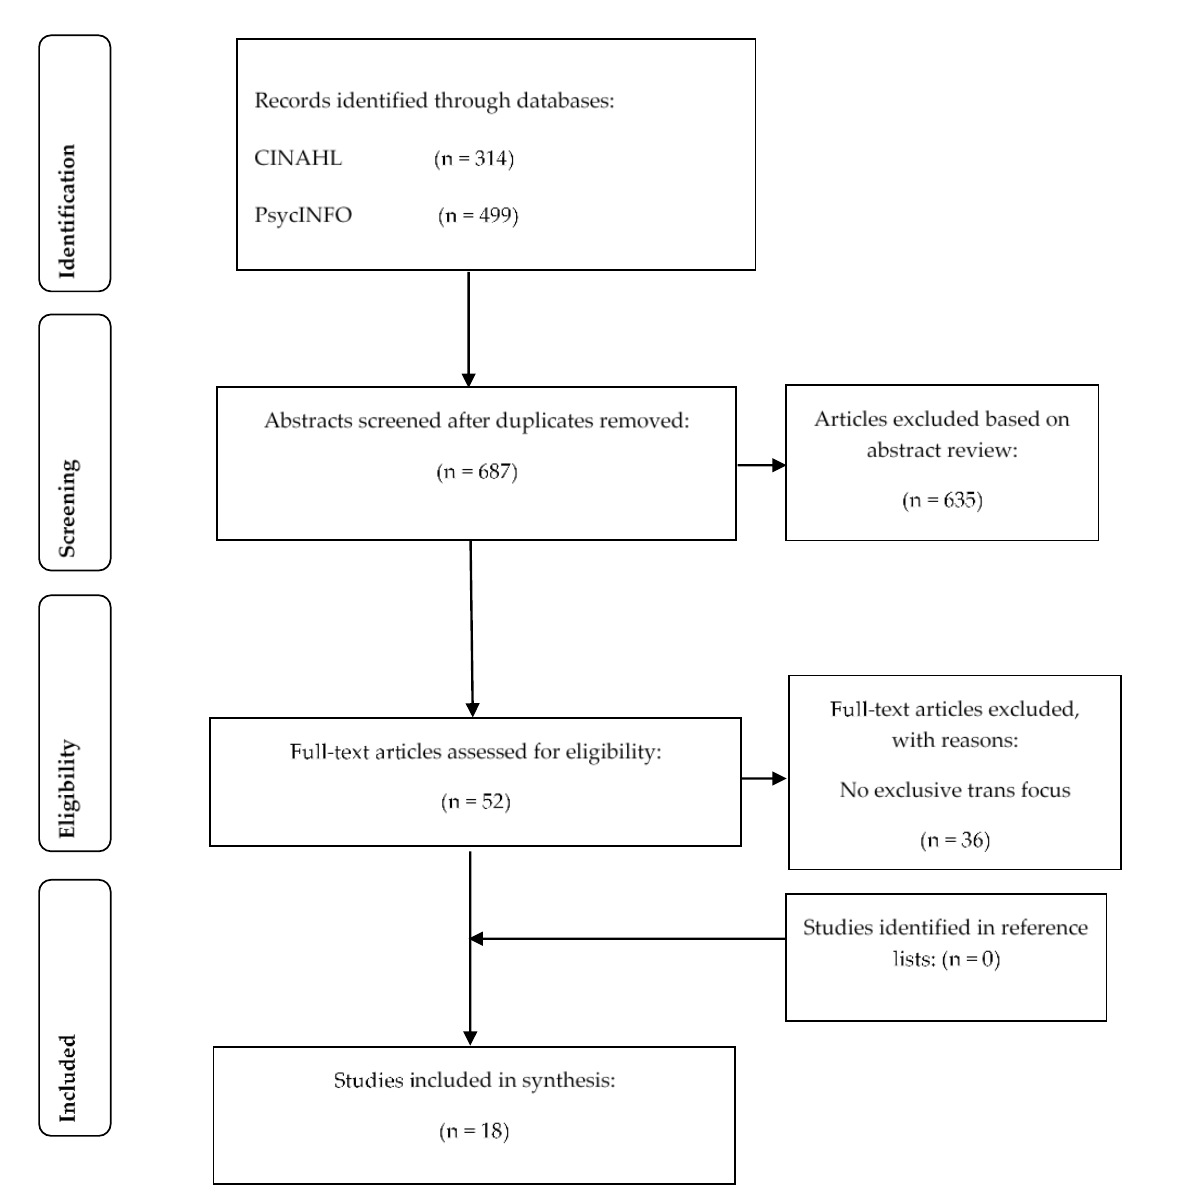
Figure 1. PRISMA Flow Diagram with search result.